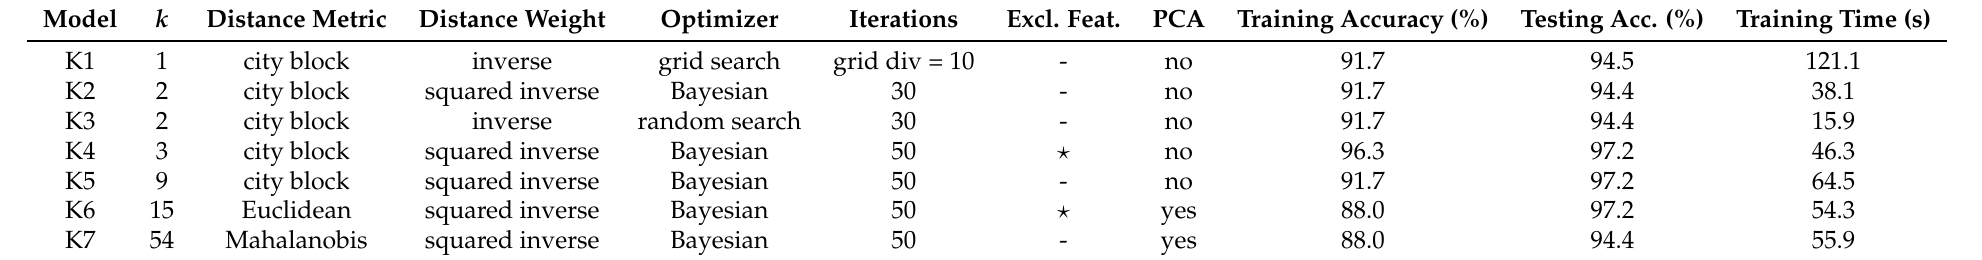
Table 3. Features of the kNN models, and relevant accuracies achieved. Excl. feat. = excluded features ( (cid:63) = top/bottom geometry, diagrid total length, maximum normal force).